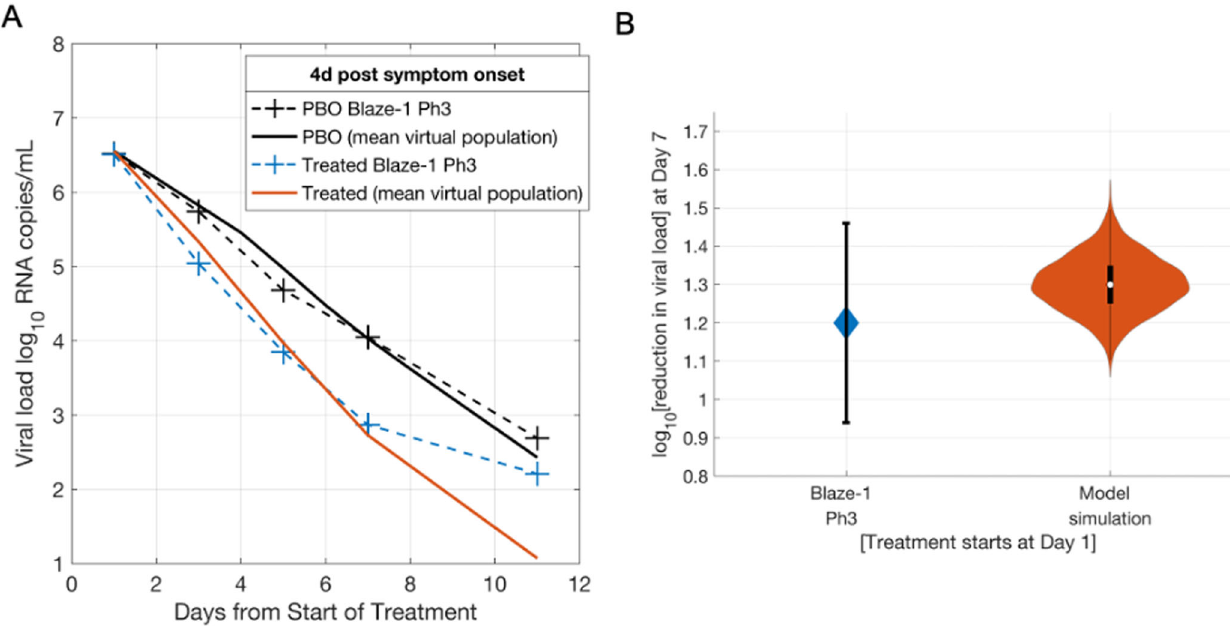
Fig. 3 Calibration of the virtual population to the viral load time course from Blaze-1 Ph3 trial of bamlanivimab and etesevimab. A Mean of the virtual population (N = 502) for the simulated placebo (PBO) group and the 2800 mg bamlanivimab + 2800 mg etesevimab simulated treated group matching the mean trial data from the observed Blaze-1 Ph3 placebo group and the 2800 mg bamlanivimab + 2800 mg etesevimab treated group. B log10 reduction in viral load from baseline at day 7 after treatment administration in the observed Blaze-1Ph 3 trial (blue) and the simulated the 2800 mg bamlanivimab + 2800 mg etesevimab treated group. Error bars represent the 95% con fi dence interval in the mean for clinical trial observations and the range of observations in the simulated virtual population. Violin plots are indicative of 99% prediction interval of mean from 1000 bootstrapped samples of the virtual population. Data extracted from ref. 22